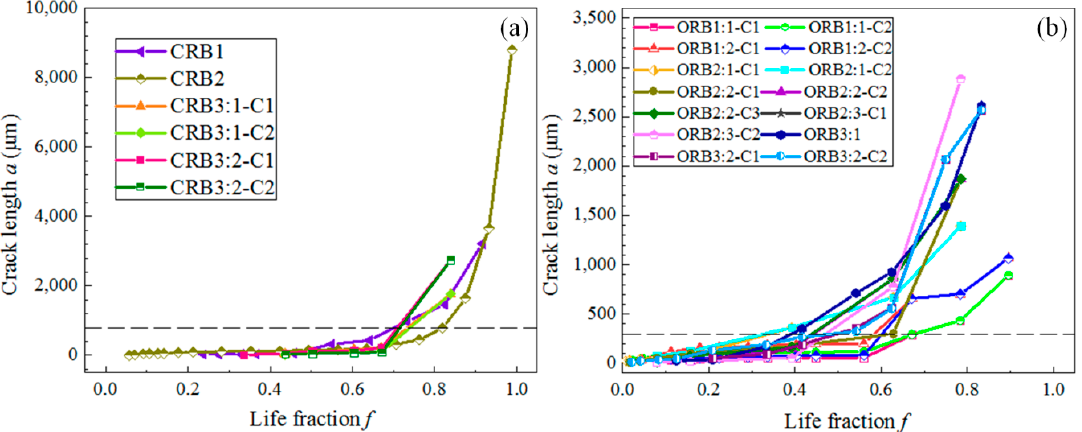
Figure 9. The curves of crack length as a function of life fraction: ( a ) Constant load; ( b ) Overload.